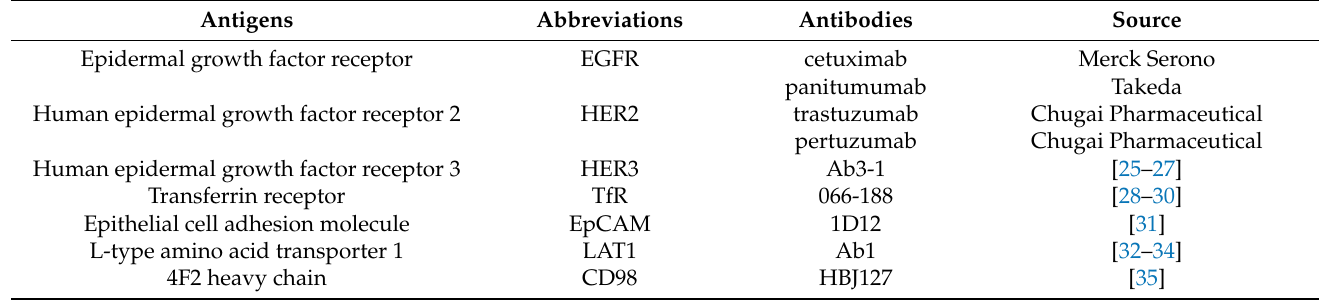
Table 1. Target antigens and antibodies used in the 64 Cu-TuBA assay